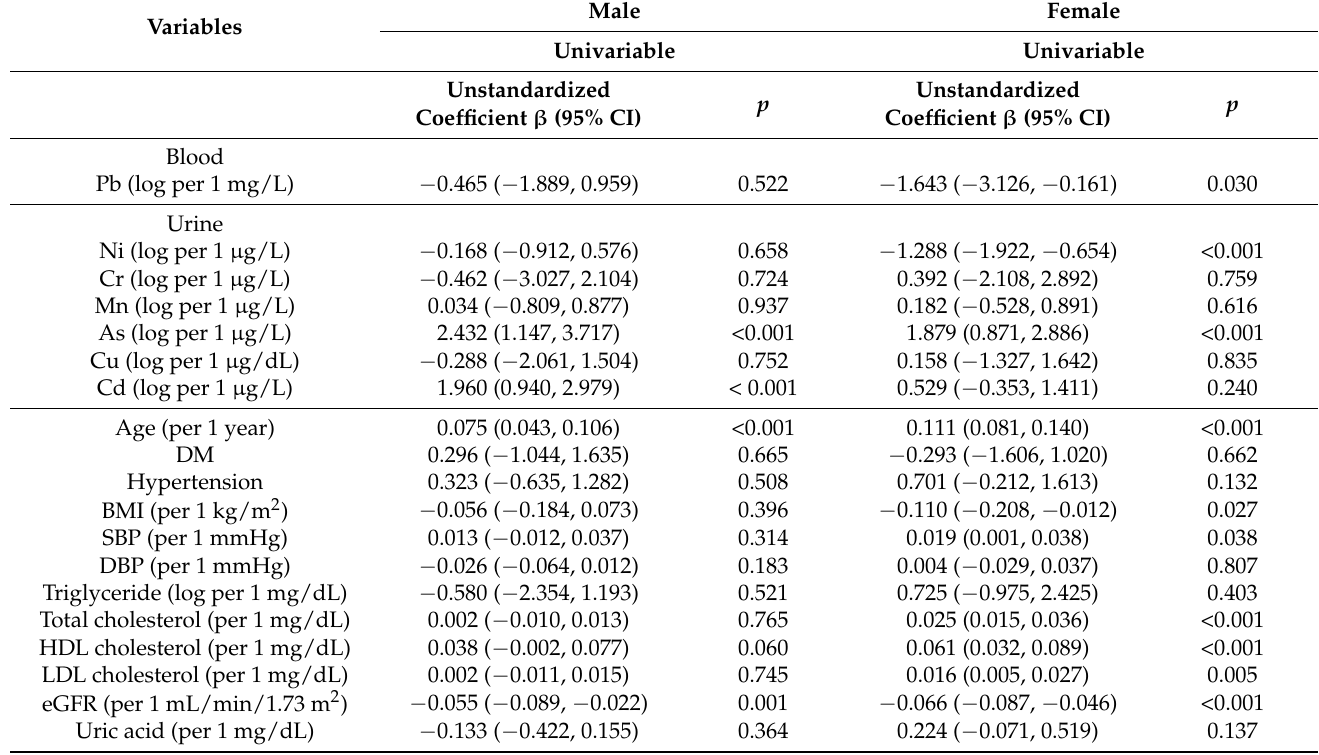
Table 4. Association of heavy metals and variables with MCV using univariable linear regression analysis by